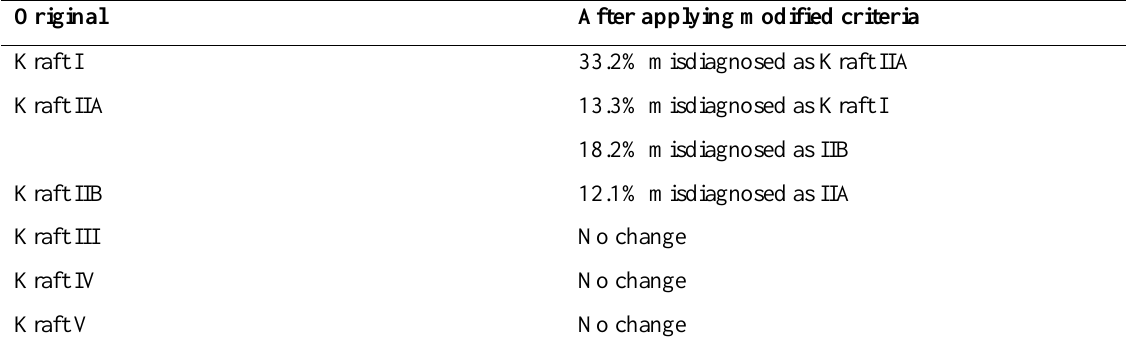
Table 1-A1: Modified Kraft pattern criteria as compared to original